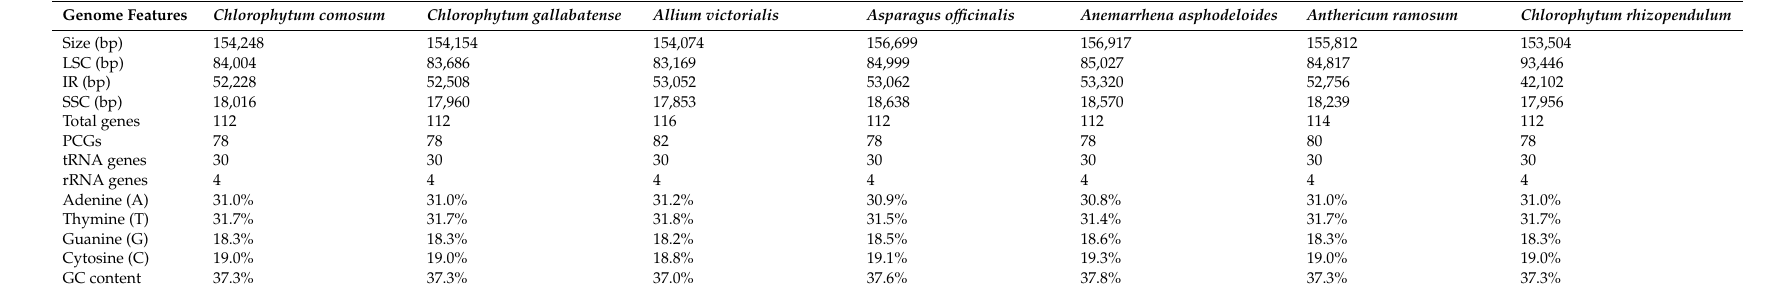
Table 1. Features of the chloroplast genomes of C. comosum and C. gallabatense and the related Asparagaceae species.